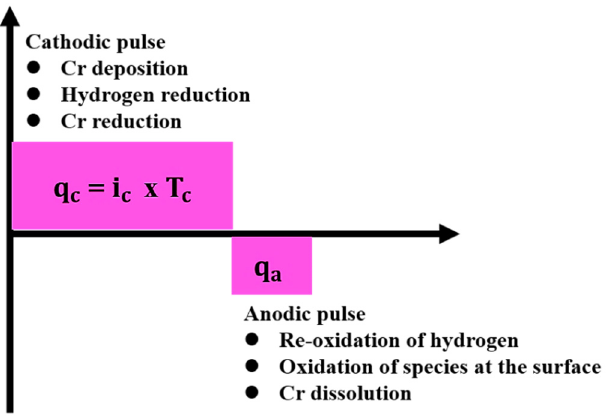
Figure 8. Principles of the pulse reversal electroplating method.